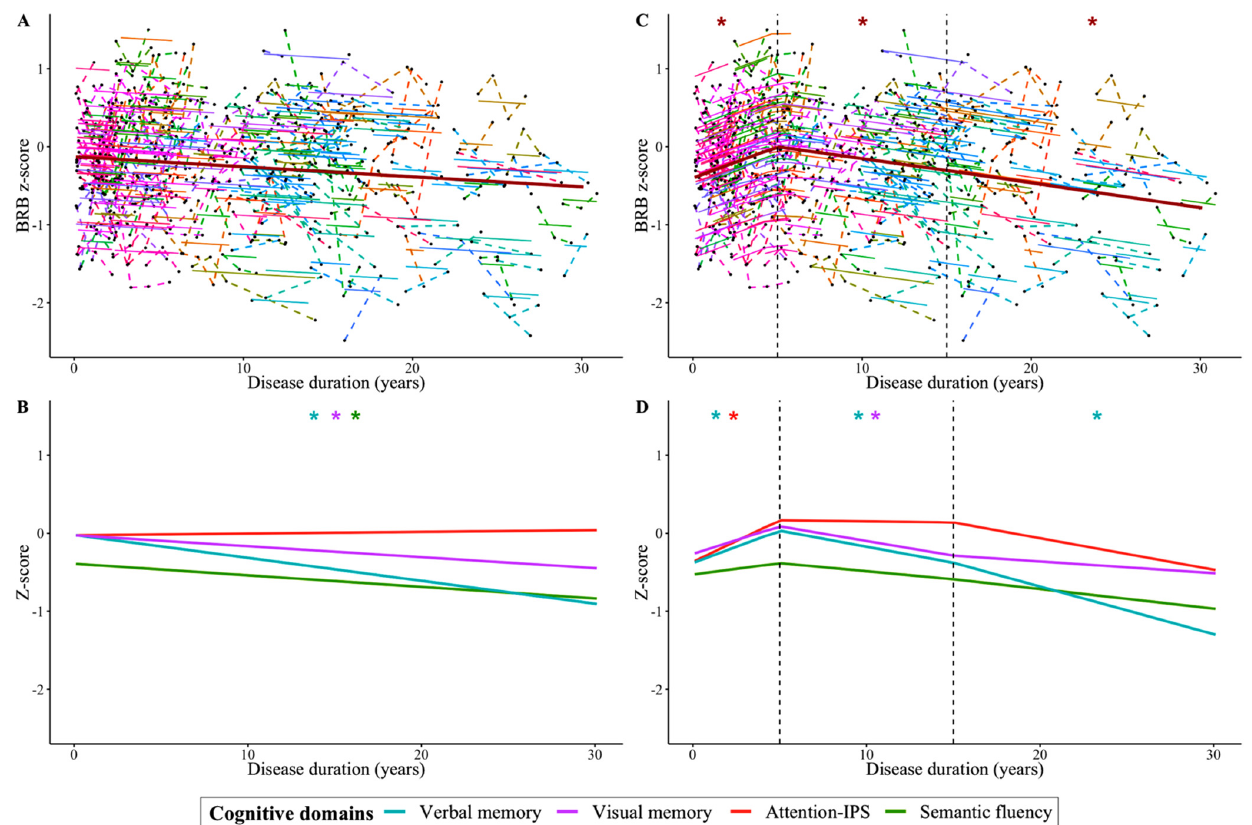
Figure 1. Dynamics of cognitive performance in MS as the disease progresses. The global cognition z-score ( A ) and cognitive domains z-score ( B ) were modeled by mixed-effect regressions. The duration of the disease was divided into three periods by spline models with two knots (at 5 and 15 years of disease duration) represented by dotted black vertical lines (for the global cognition z-score ( C ) and each domain z-score ( D ). Black points joined by a broken line represent the individual trajectories of the changes in the global cognition z-scores, the continuous lines represent the individual fit of the model, and the thicker brown line represents the population model ( A , C ). Population model lines of cognitive domains are differentiated by color ( B , D ): blue for verbal memory, purple for visual memory, red for attention-IPS, and green for semantic fluency. The x-axis represents the time in years from clinical onset. All models were fitted using the lme4 package in R version 3.5.2 (R Foundation for Statistical Computing: * p < 0.05).